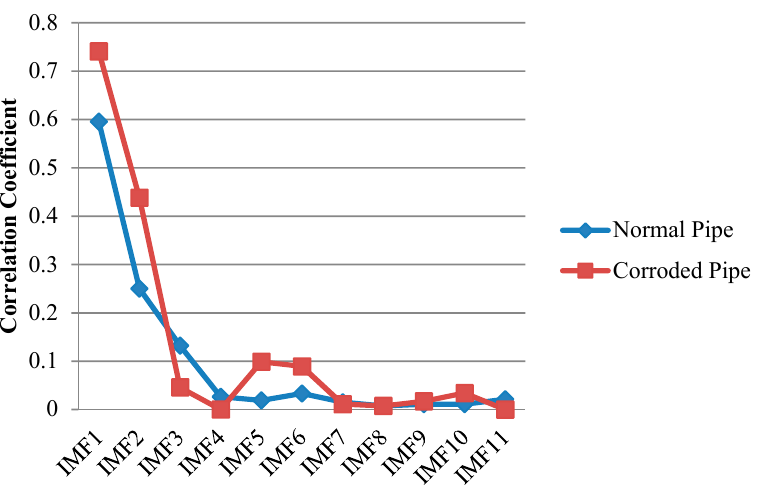
Figure 15. Decomposition of signals into their IMFs by SEMD for the pristine pipe ( a ); and the pipe with a natural corrosion ( b ).